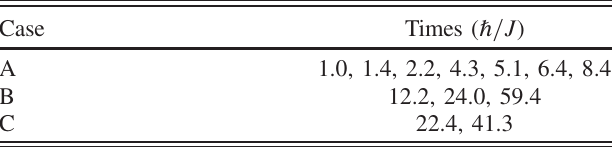
TABLE III. Evolution times used for each case in Fig. 2 of main